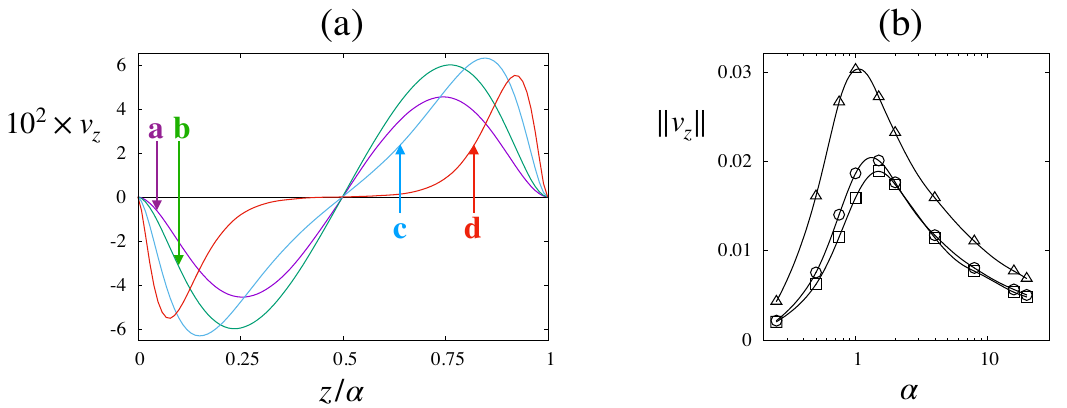
Figure 7. Spatial structure of the dimensionless off-plane velocity component v z ( x , y , z ) on selected surfaces within the 3D domain.